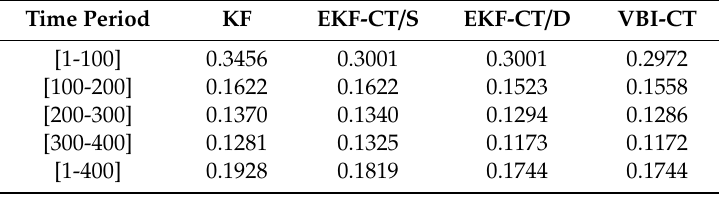
Table 5. Comparison of tracking error of di ff erent algorithms with σ 2 = 0.5.